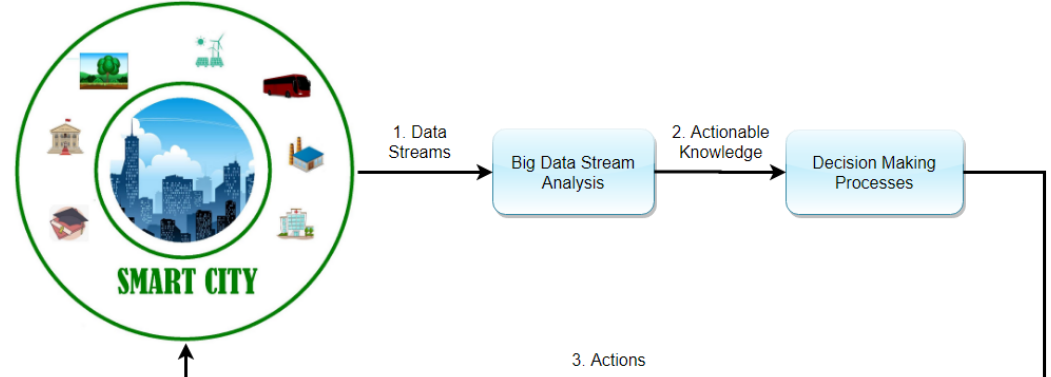
Figure 1. The three phases of smart city operation.